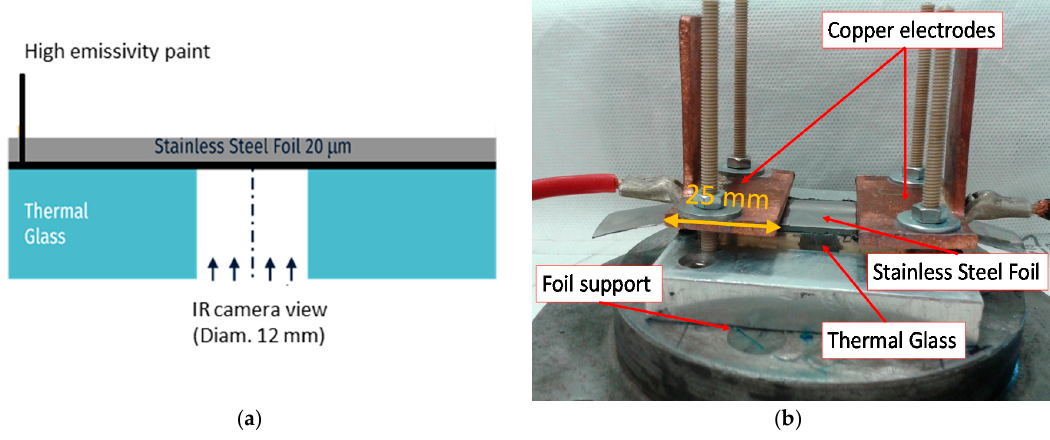
Figure 2. ( a ) Detail of the stainless-steel foil and relative position of the IR camera; ( b ) Foil support and heating assembly.